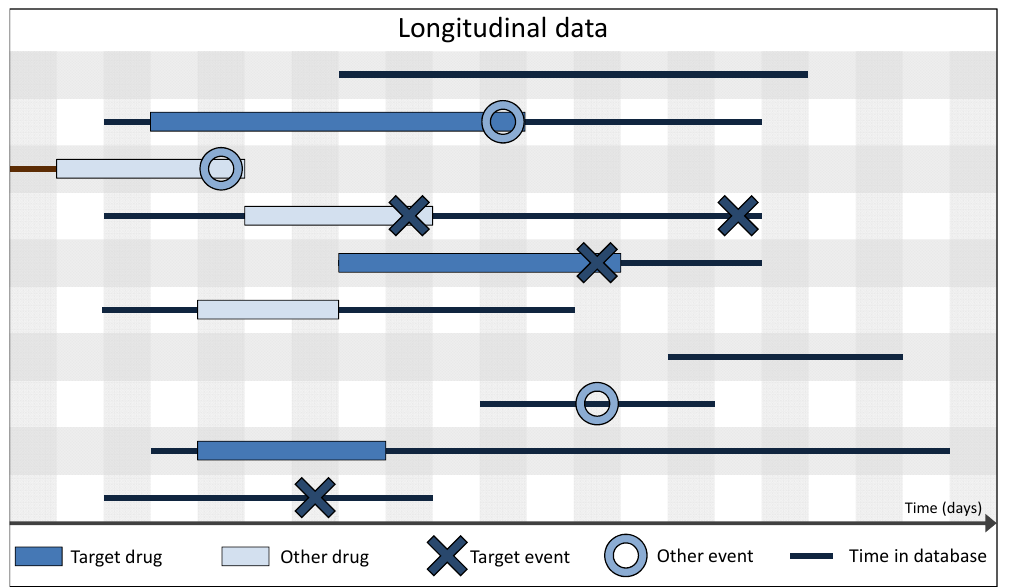
Figure 3. Schematic overview of the amount of information per patient contained in longitudinal data over time, where the information simultaneously contained in spontaneous reporting (SR) data is highlighted.